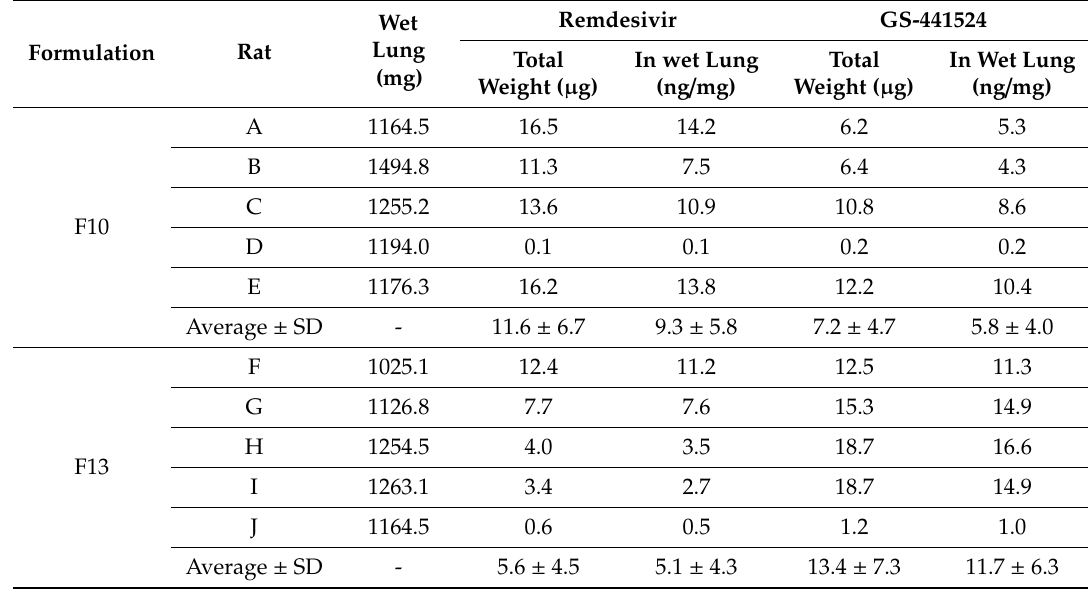
Table 5. Amount of remdesivir and GS-441524 in the lungs at 24 h following a single inhalation administration of F10 and